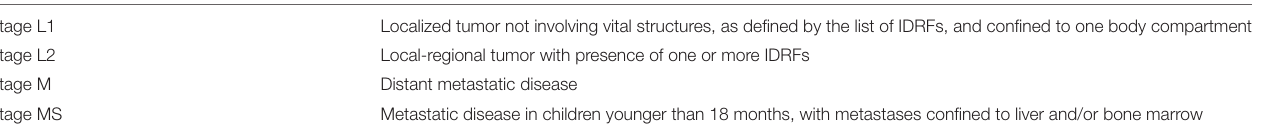
TABLE 2 | INRG Tumor staging system (29). Stage L1 Stage L2 Local-regional tumor with presence of one or more IDRFs Stage M Distant metastatic disease Stage MS Metastatic disease in children younger than 18 months, with metastases confined to liver and/or bone marrow IDRFs, Image-defined risk